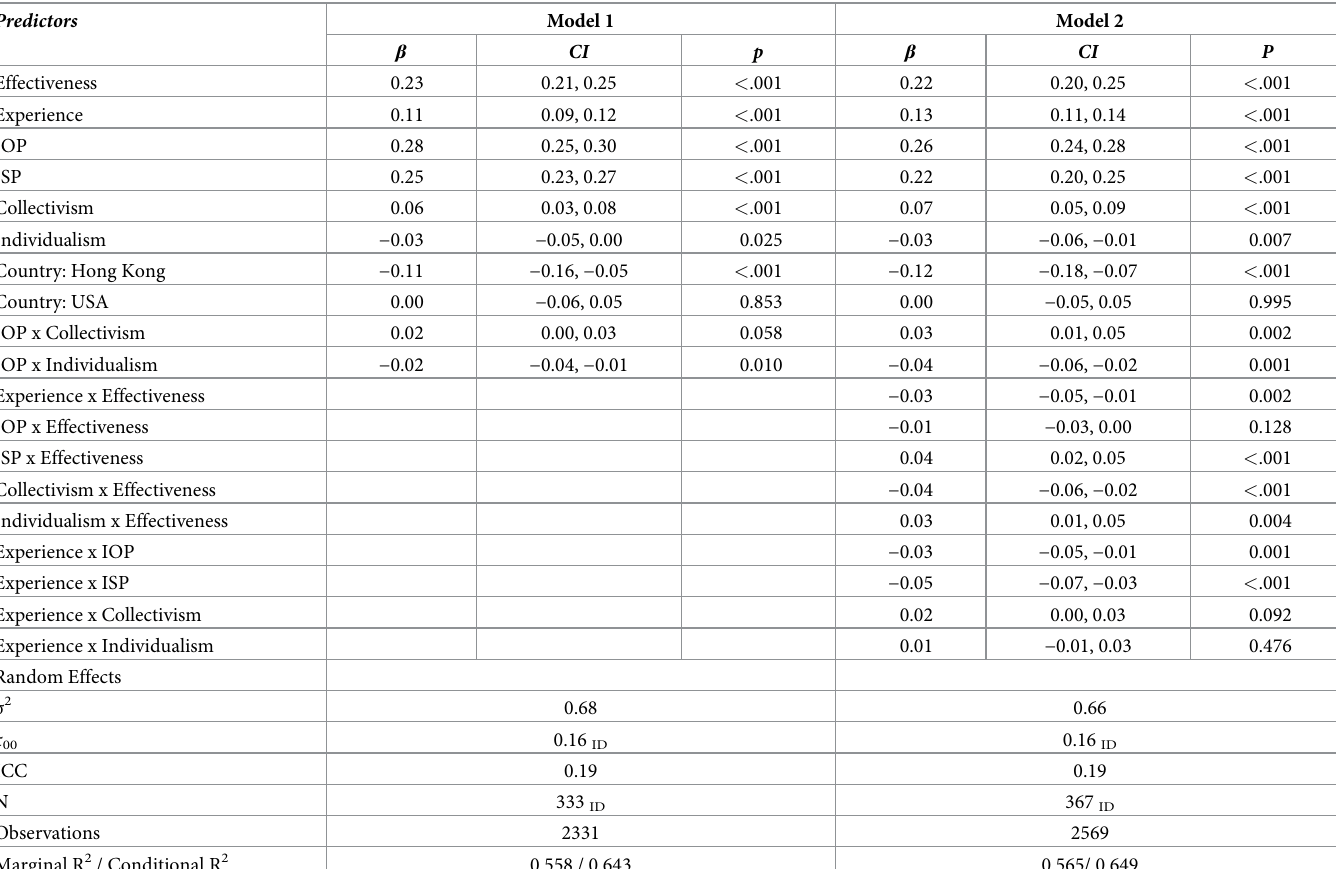
Table 1. Mixed effects regressions models testing the pre-registered hypotheses (Model 1), and exploring interactions (Model